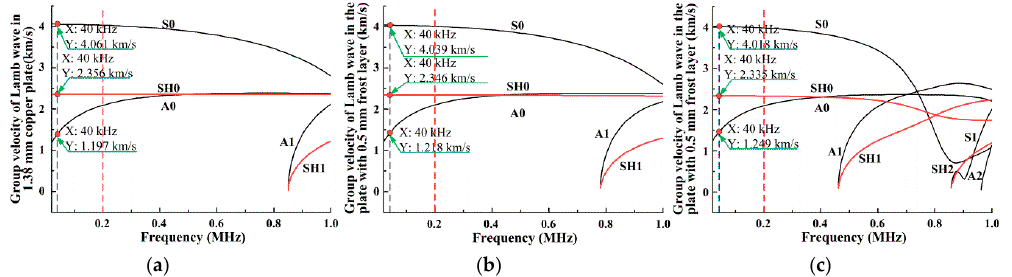
Figure 6. Group velocities of the Lamb wave and SH wave in a vibration transfer plate with/without a frost layer. ( a ) 1.38-mm-thick copper plate ( b ) plate with a 0.5-mm-thick frost layer ( c ) plate with a 1.0-mm-thick frost layer.